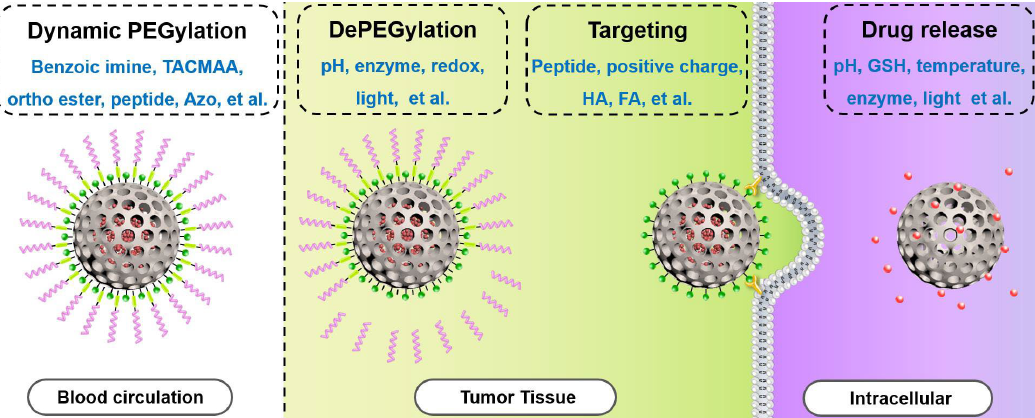
Scheme 1. Schematic illustration of DePEGylation for “tumor-triggered” targeting or intracellular drug release.